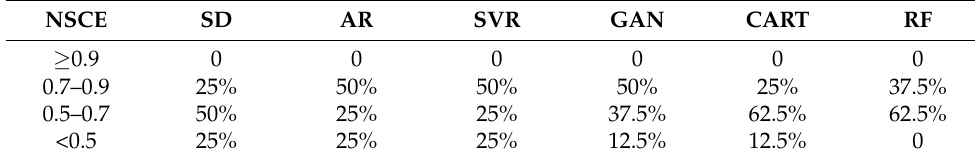
Table 10. NSCE statistical results.